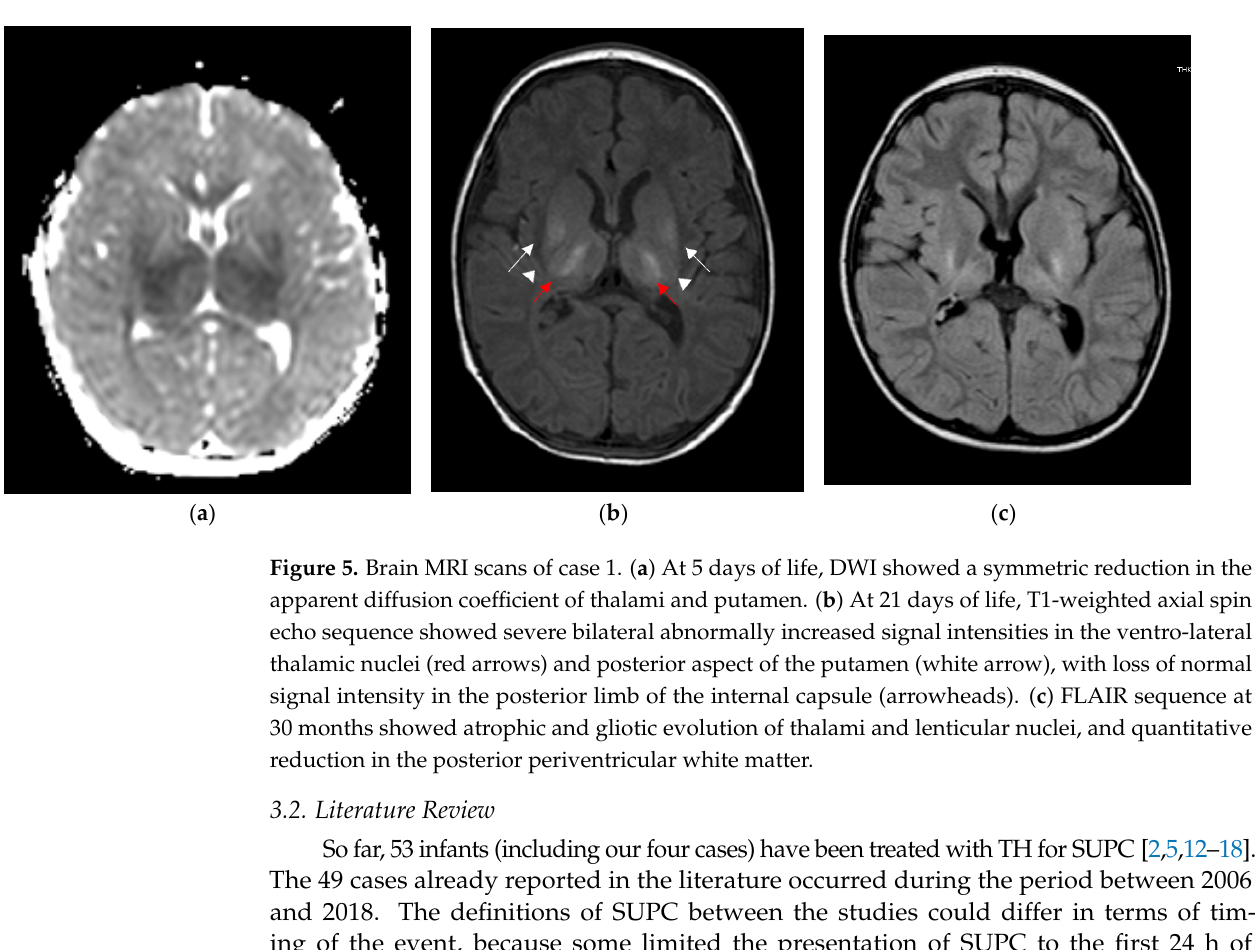
Figure 4. Brain MRI scans of case 4. ( a–c ) At 5 days of life, T1-weighted axial spin echo sequence ( b ) showed small foci of increased signal intensity in the fronto-parietal-occipital white matter (arrows), with a reduced apparent diffusion coefficient on DWI (arrows, a ). Gradient echo sequence ( c ) shows a prominent aspect of the profound medullary veins. ( d ) At 64 days of life, T2-weighted and SWI sequences show reduced extension and appearance of the focal white matter lesions, with a slight increase in the ventricular system.